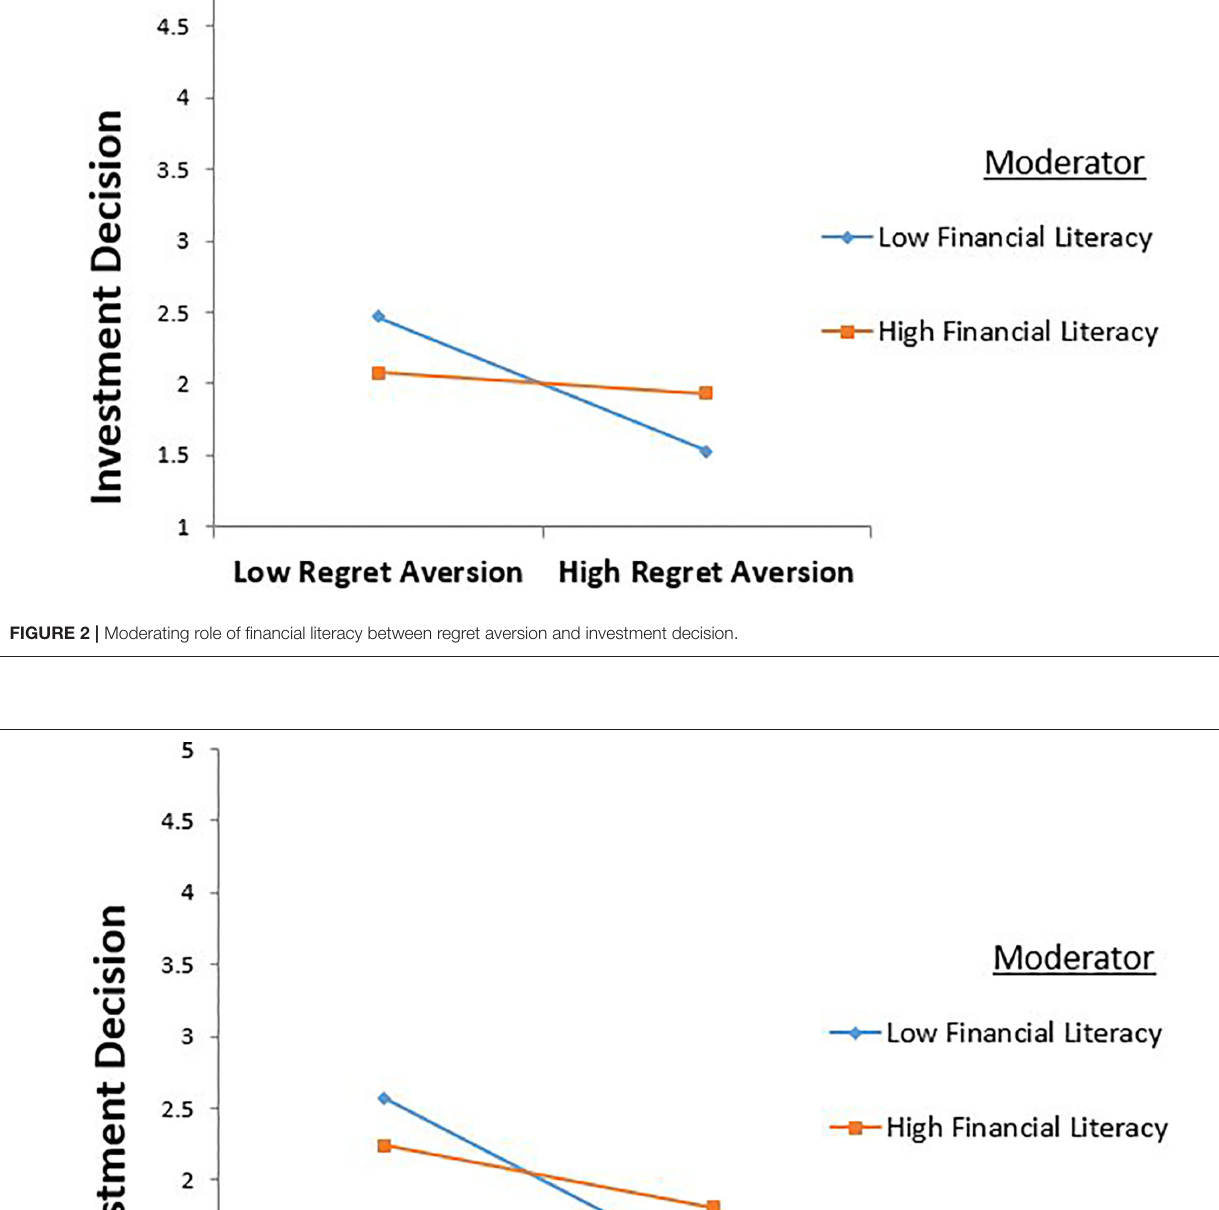
Frontiers in Psychology |